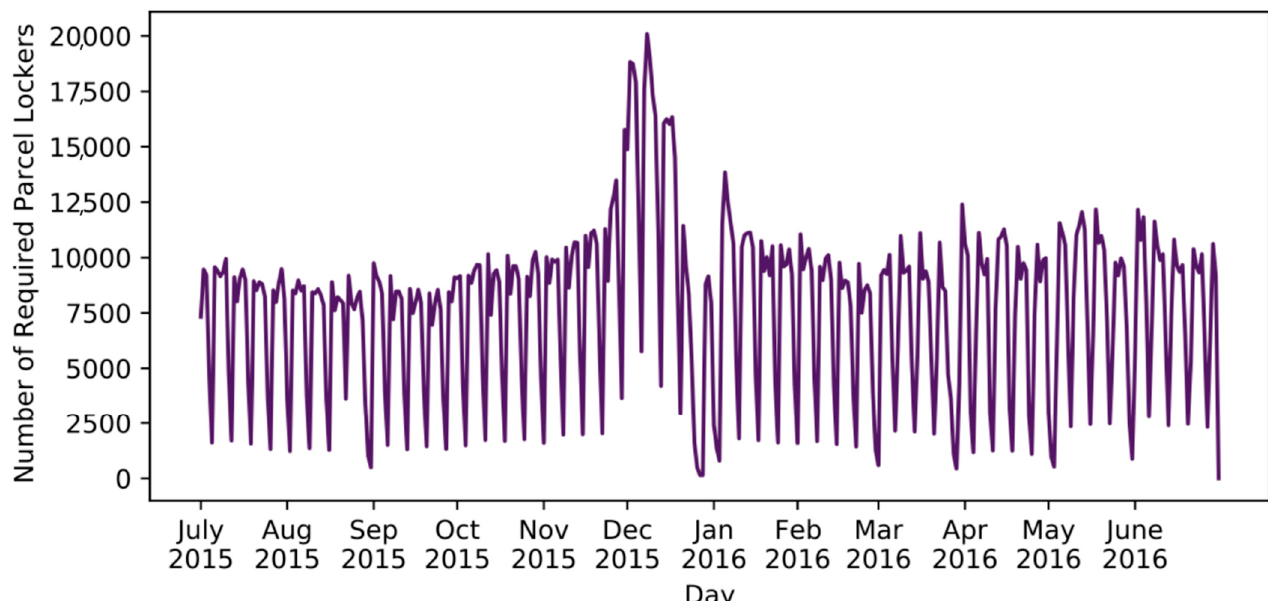
Figure 1. Number of parcel lockers required per day (Density 1.0).